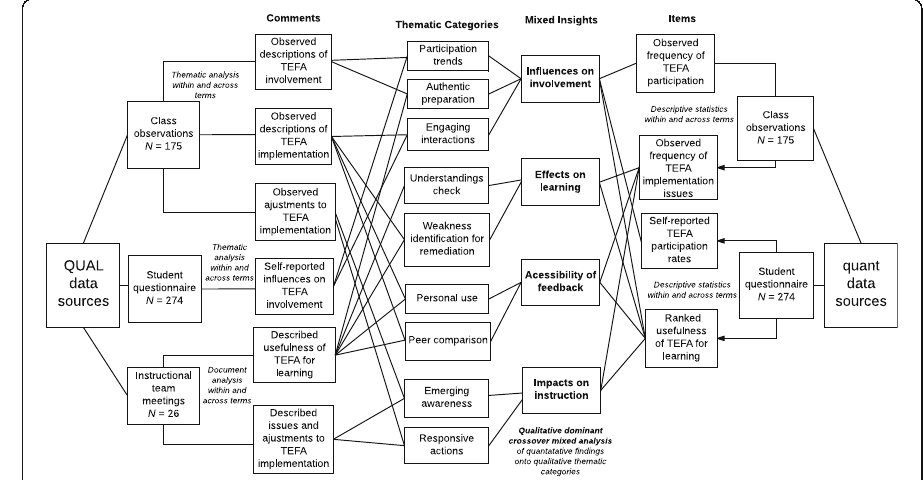
Fig. 2 Study ’ s data collection, analysis, and